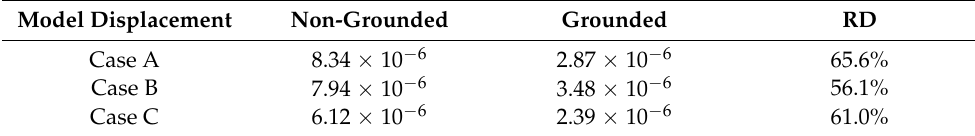
Table 5. Whole-body average SAR (W/kg). RD refers to relative